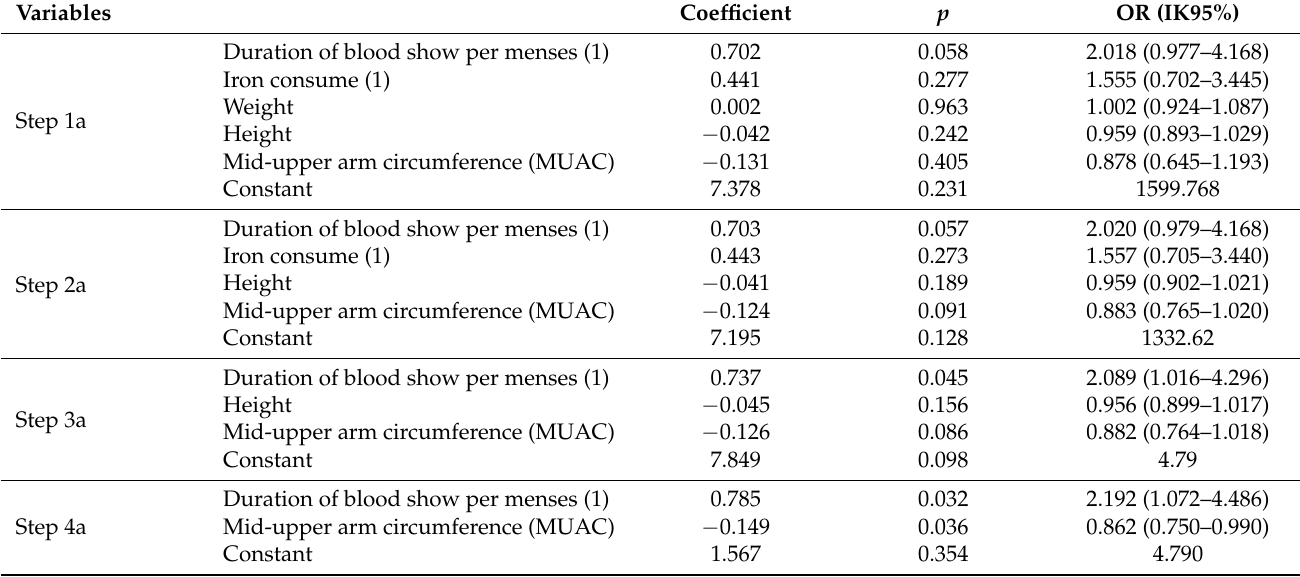
Table 4. The Most Influence Factors of Anemia (Multivariate